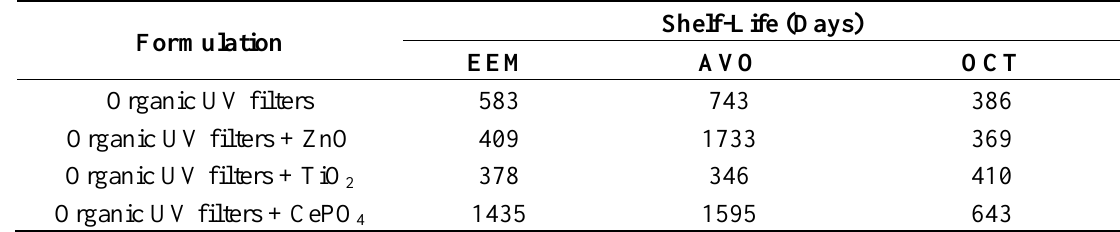
Table 1. Shelf lives of the organic UV filters ethylhexyl methoxycinnamate (EEM), avobenzone (AVO) and octocrylene (OCT), alone or in combination with the inorganic UV filters ZnO, TiO and CePO , stored at 45 °C and 37 °C, 75% RH. 2 4